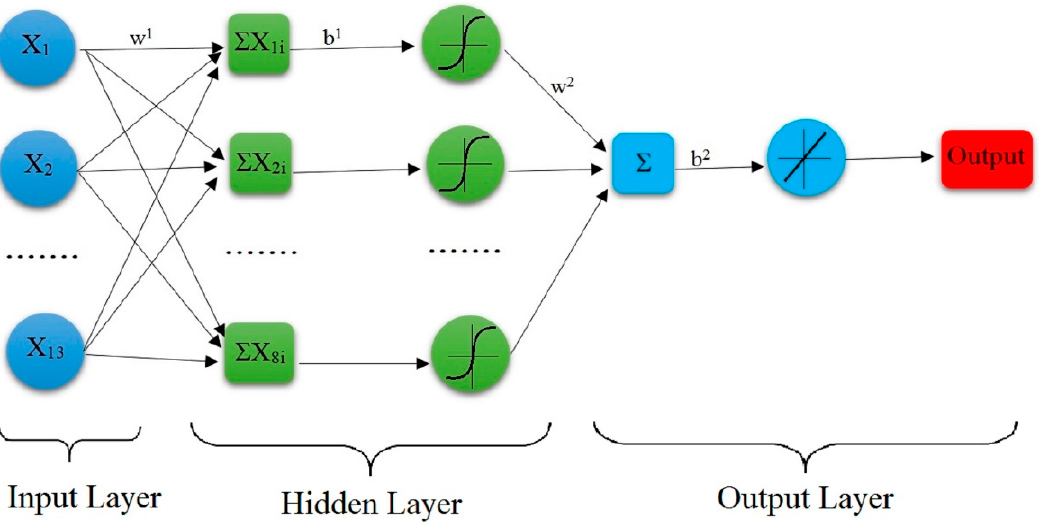
Figure 3. ANN structure for learning and modelling in this work. Input layer includes 13 neurons while there are 8 neurons in the Hidden layer and 1 neuron in Output layer.